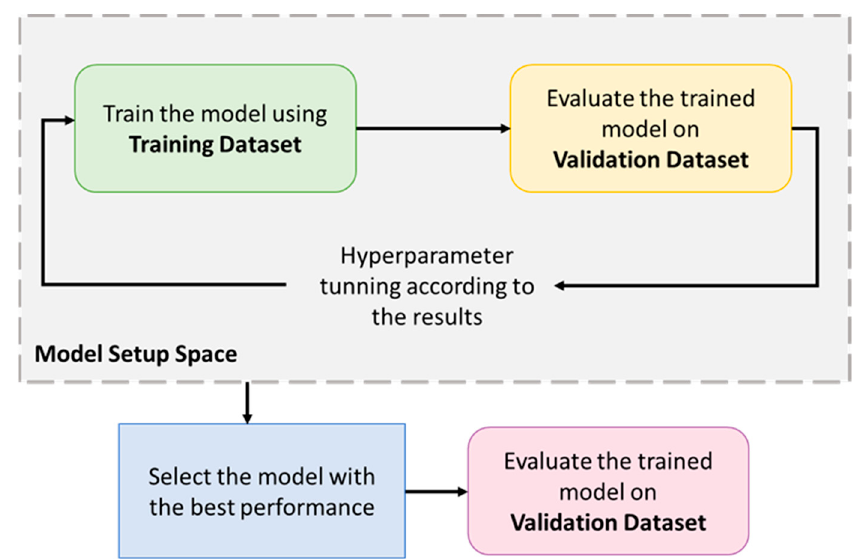
Figure 6. The differences between the training dataset, validation dataset, and testing dataset. The utilized network consists of two parallel input layers, three hidden layers with ReLU activation for all layers and 36 neurons in each layer, and one output layer. The